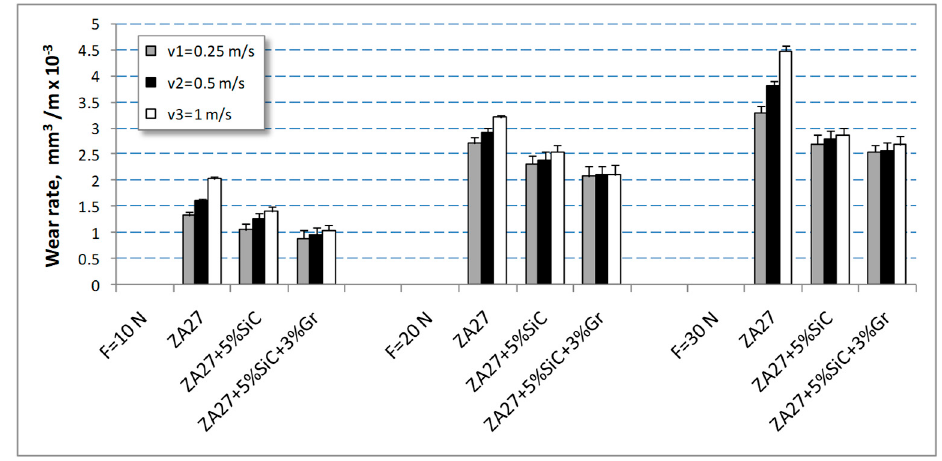
Figure 6. The wear-rate of the tested materials in the dry sliding conditions.